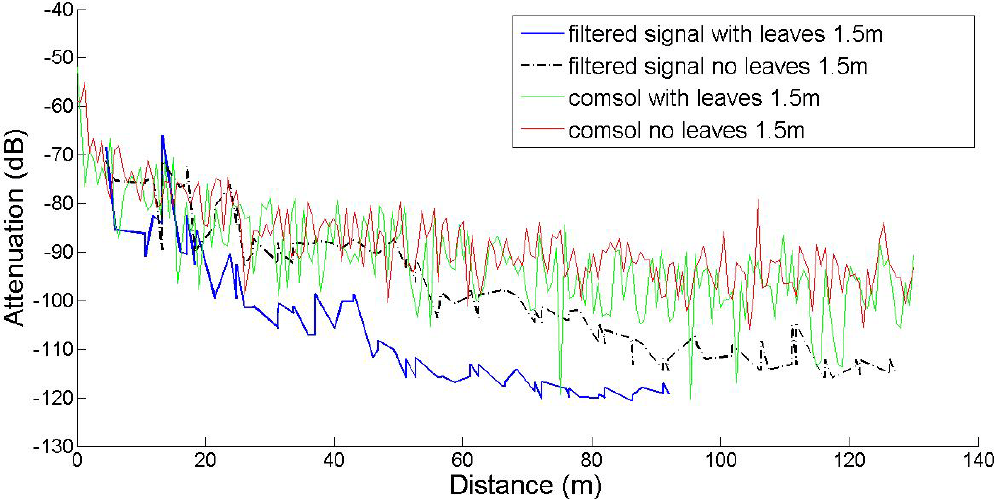
Figure 6. Attenuation computations and measurements for transmitter and receiver height equal to h = 1.5